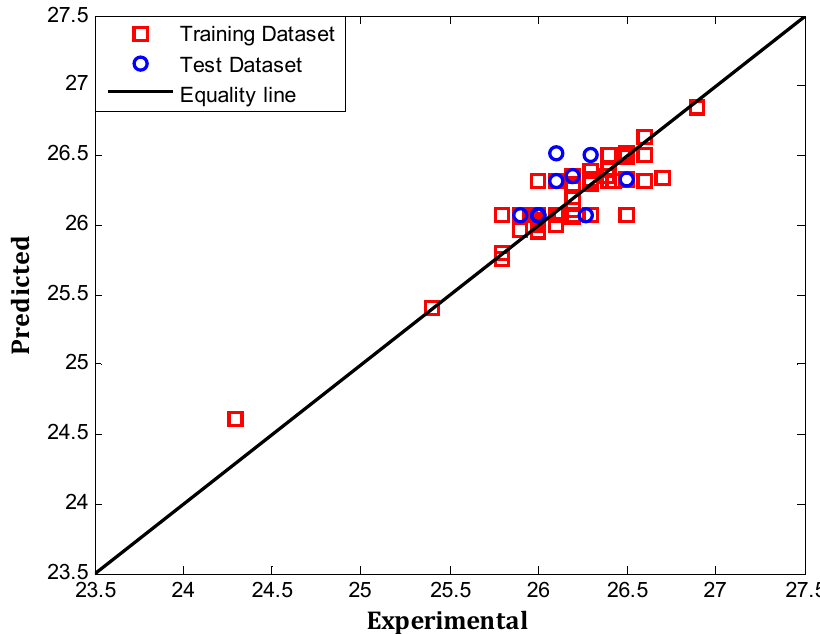
Figure 5. The e ffi ciency of the optimum MLP model for prediction of all the Figure 5. The efficiency of the optimum MLP model for prediction of all the datasets.